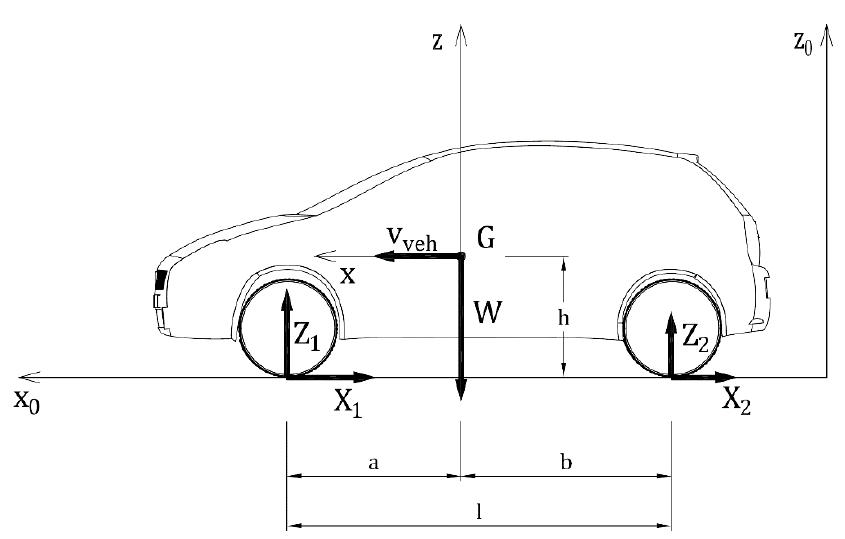
Figure 4. Forces acting on the vehicle during braking [30].